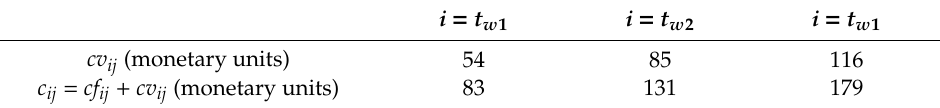
Table A7. Total variable and unit costs relating to per-COVID treatments.